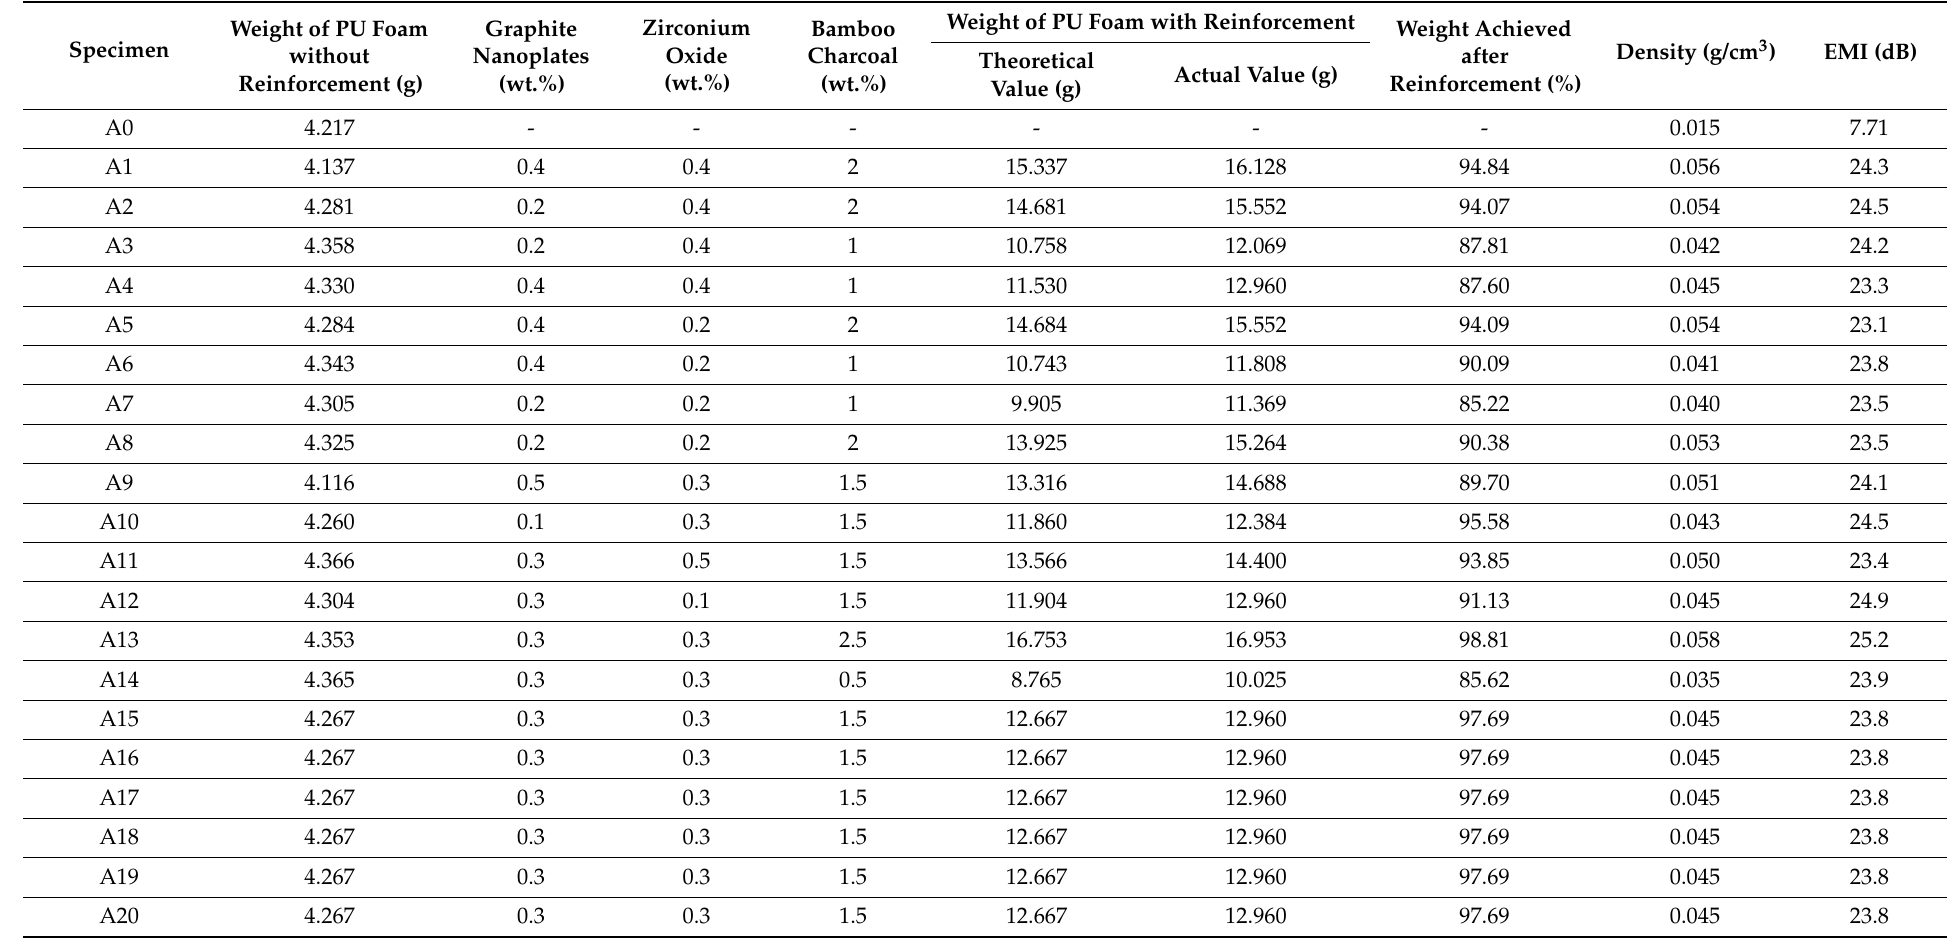
Table 3. Physical properties and EMI results for the experimental design